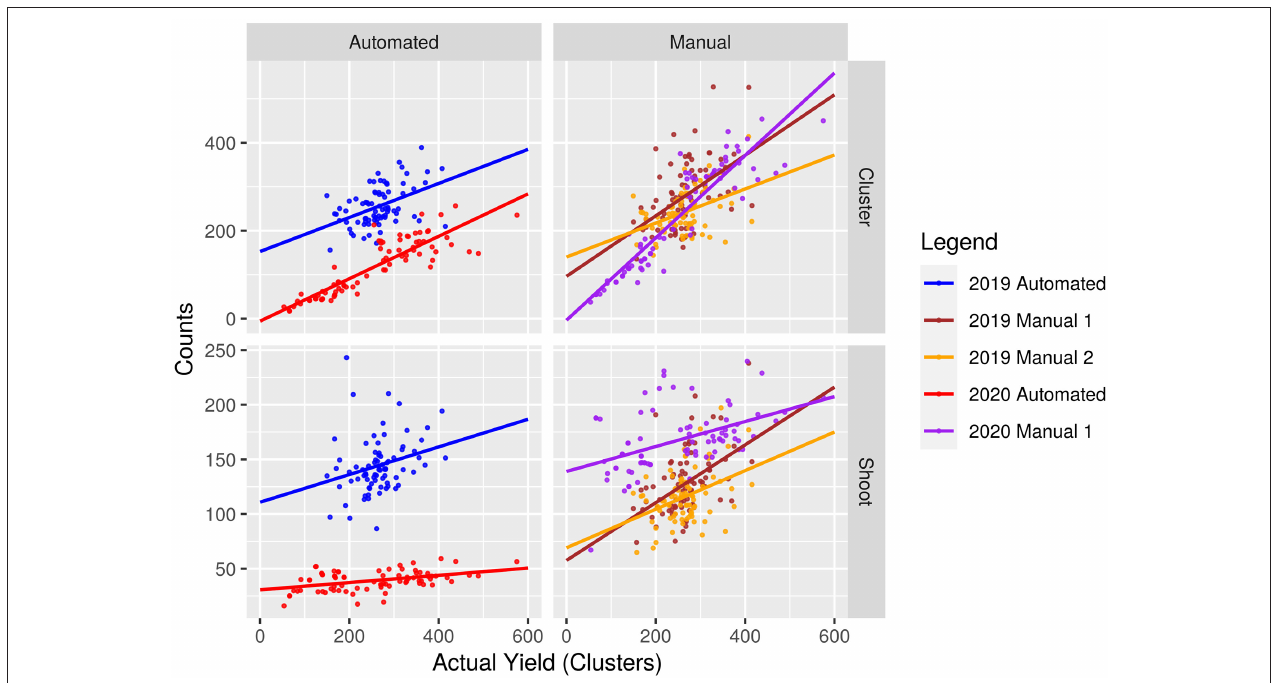
FIGURE 3 | Manual and uncalibrated automated counts of clusters and shoots plotted against the actual number of clusters in each panel with lines of best